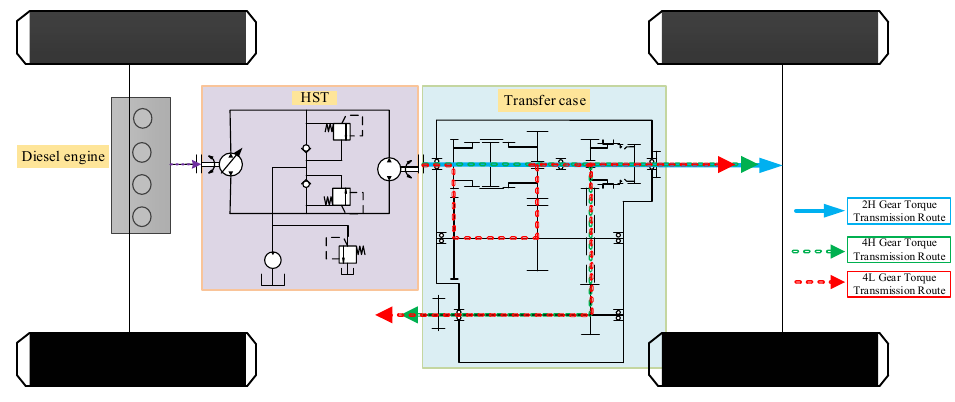
Figure 2. Chassis drive train diagram.